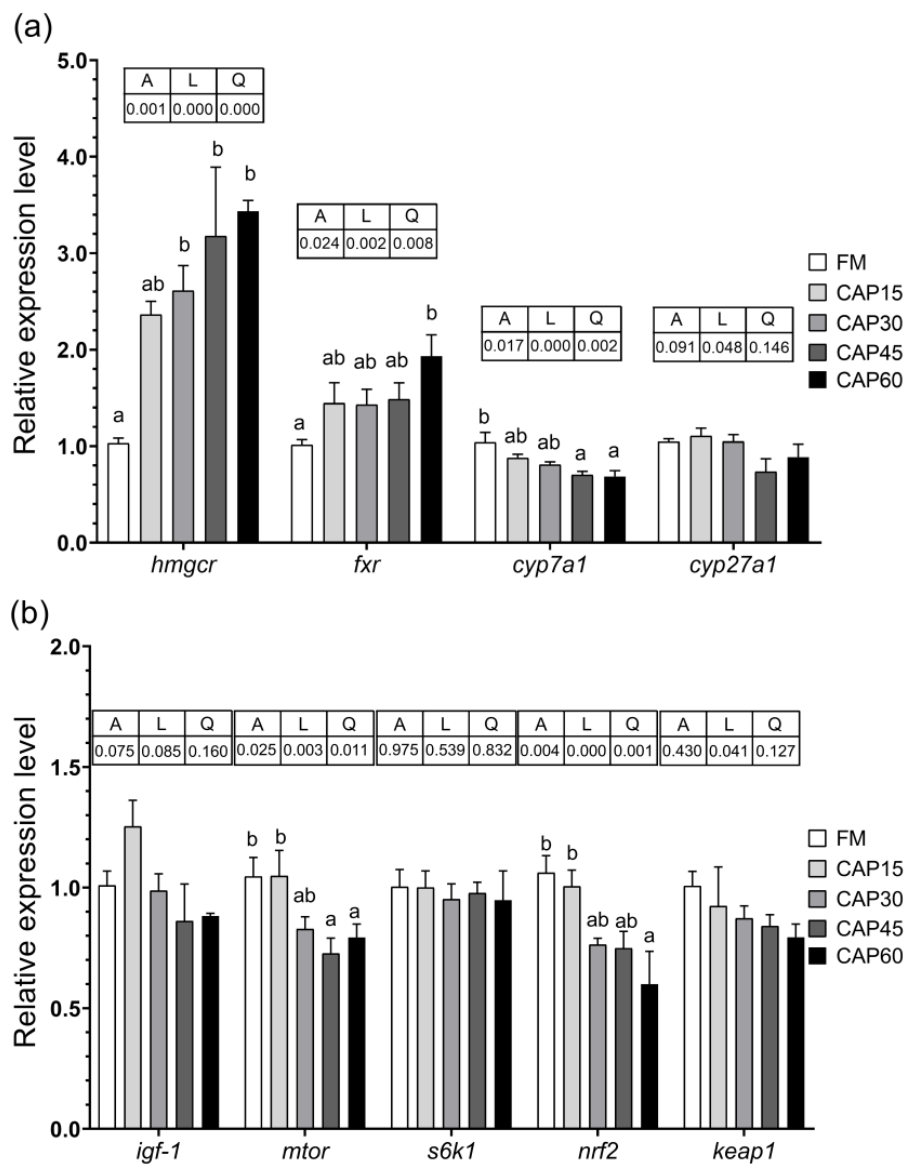
Figure 4. Relative mRNA expression level in liver of pearl gentian grouper fed gradient substitution of fishmeal in the diet with CAP. ( a ). Cholesterol and bile acid metabolization related genes; ( b ). mTOR signaling pathway and Nrf2 and signaling pathway related genes. hmgcr, 3-hydroxy-3-methylglutaryl coenzyme A reductase ; fxr , farnesoid X receptor ; cyp7a1 , cholesterol 7 α -hydroxylase ; cyp27a1 , cholesterol 27 α -hydroxylase ; igf-1 , insulin-like growth factor ; akt , serine/threonine-protein kinase ; mtor , mammalian target of rapamycin ; s6k1 , ribosomal protein S6 kinase 1 ; nrf2 , nuclear erythroid 2-related factor 2 ; keap1 , kelch-like ECH associating protein 1 . Bars represent means ± pooled standard error of the mean (SEM), n = 4. Different superscript letters are significantly different ( p < 0.05) among treatments. Significance probability associated with the F-statistic. A: Analysis of Variance; L: analysis of Linear trend; Q: Analysis of Quadratic